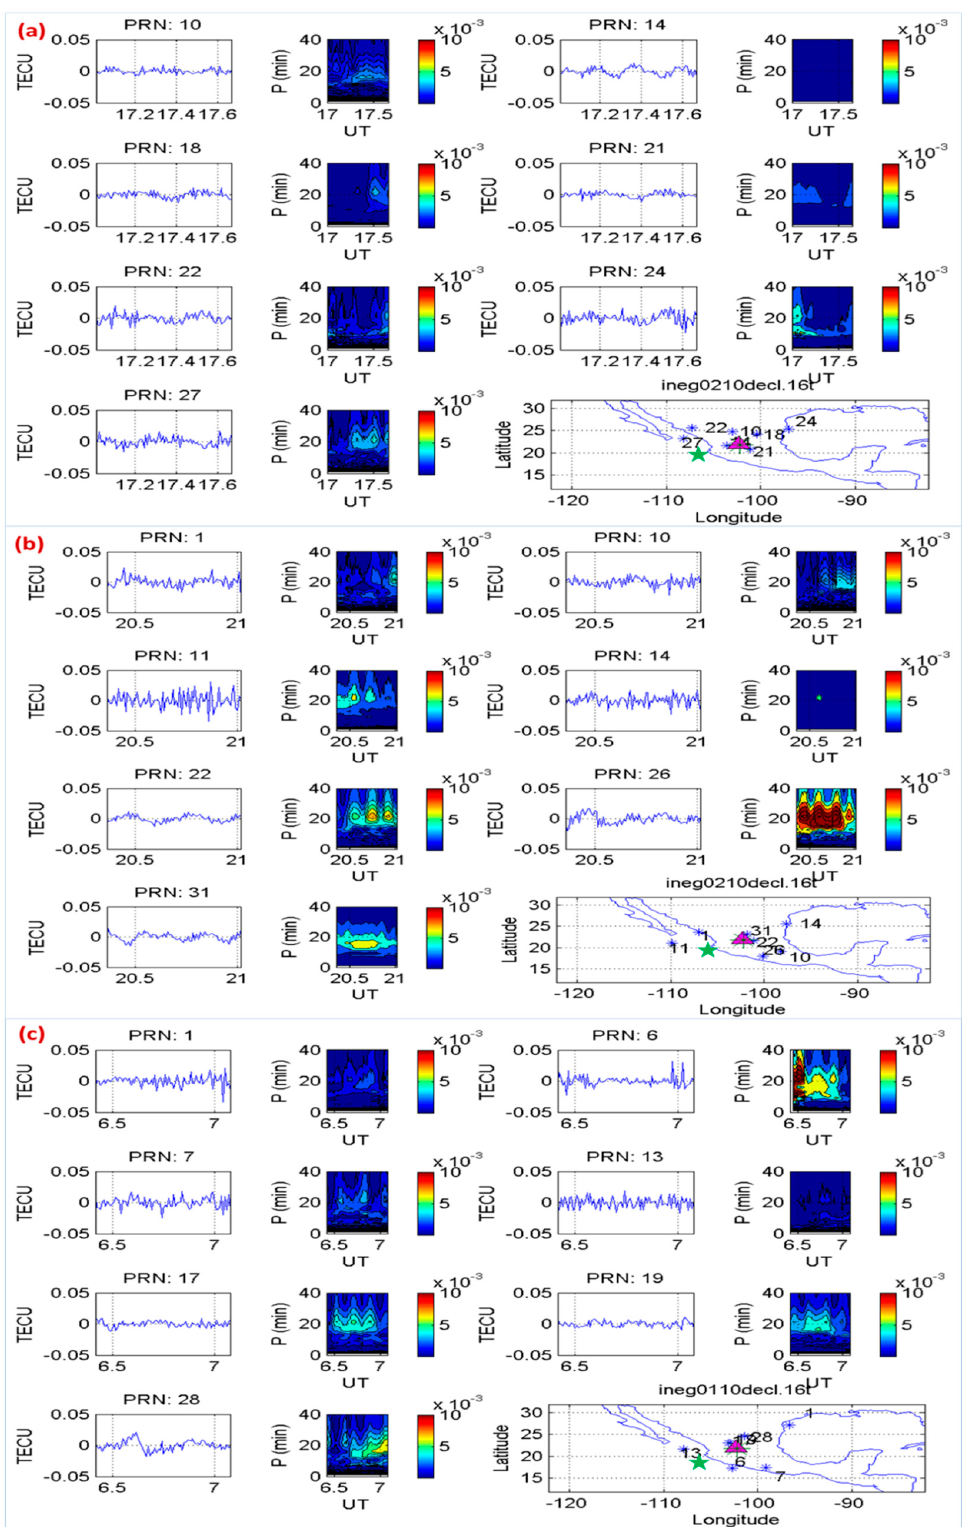
Figure 13. Fluctuations of differential slant TEC obtained from the INEG station and PRN satellites passing over the earthquake preparation area on: ( a ) 21 January 2016 at 17.0–17.6 UT (upper panel) one hour before the event, ( b ) 21 January 2016 at 20.5–21.0 UT (middle panel) and ( c ) 11 January 2016 at 6.5–7.0 UT (lower panel). Power spectrograms of normalized amplitude are also shown. Maps show earthquake epicenter (green asterisk), INEG station (pink triangle), number and position of satellite (blue asterisks).